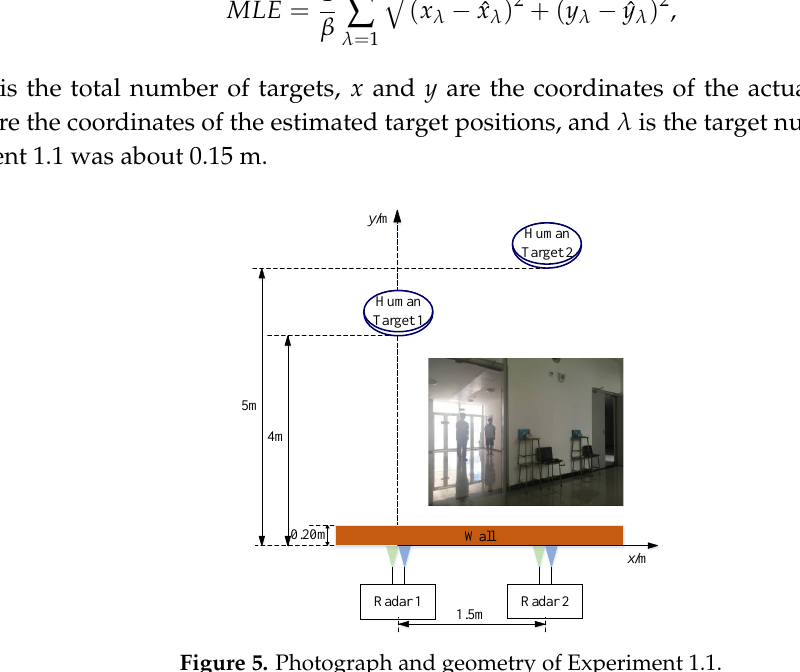
Figure 5. Photograph and geometry of Experiment